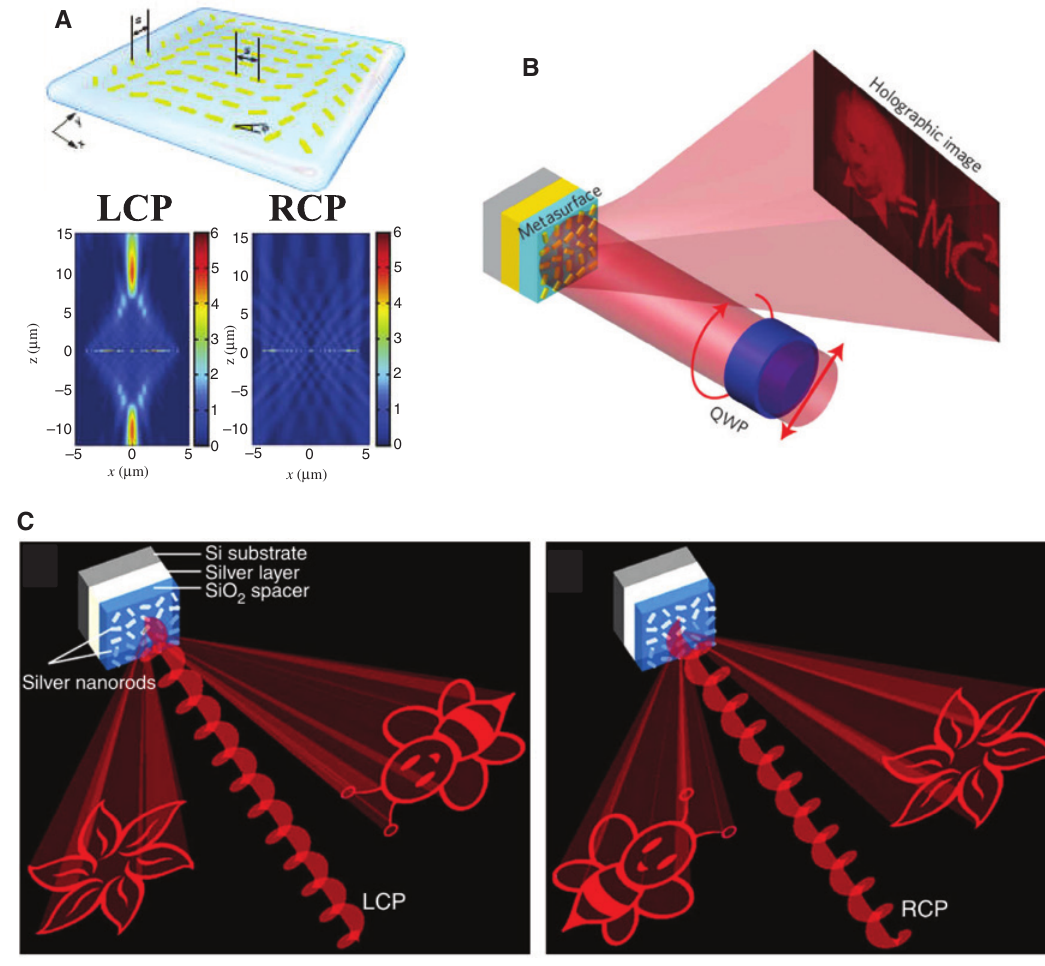
Figure 11: Geometric phase enabled flat optics and hologram. (A) Dual-polarity plasmonic flat lens for visible light. Reprinted from Ref. [131]. (B) Geometric phase enabled holographic scheme and recon- struction procedure. Reprinted from Ref. [135]. (C) Helicity multiplexed metasurface hologram with dual holographic images. Reprinted from Ref.